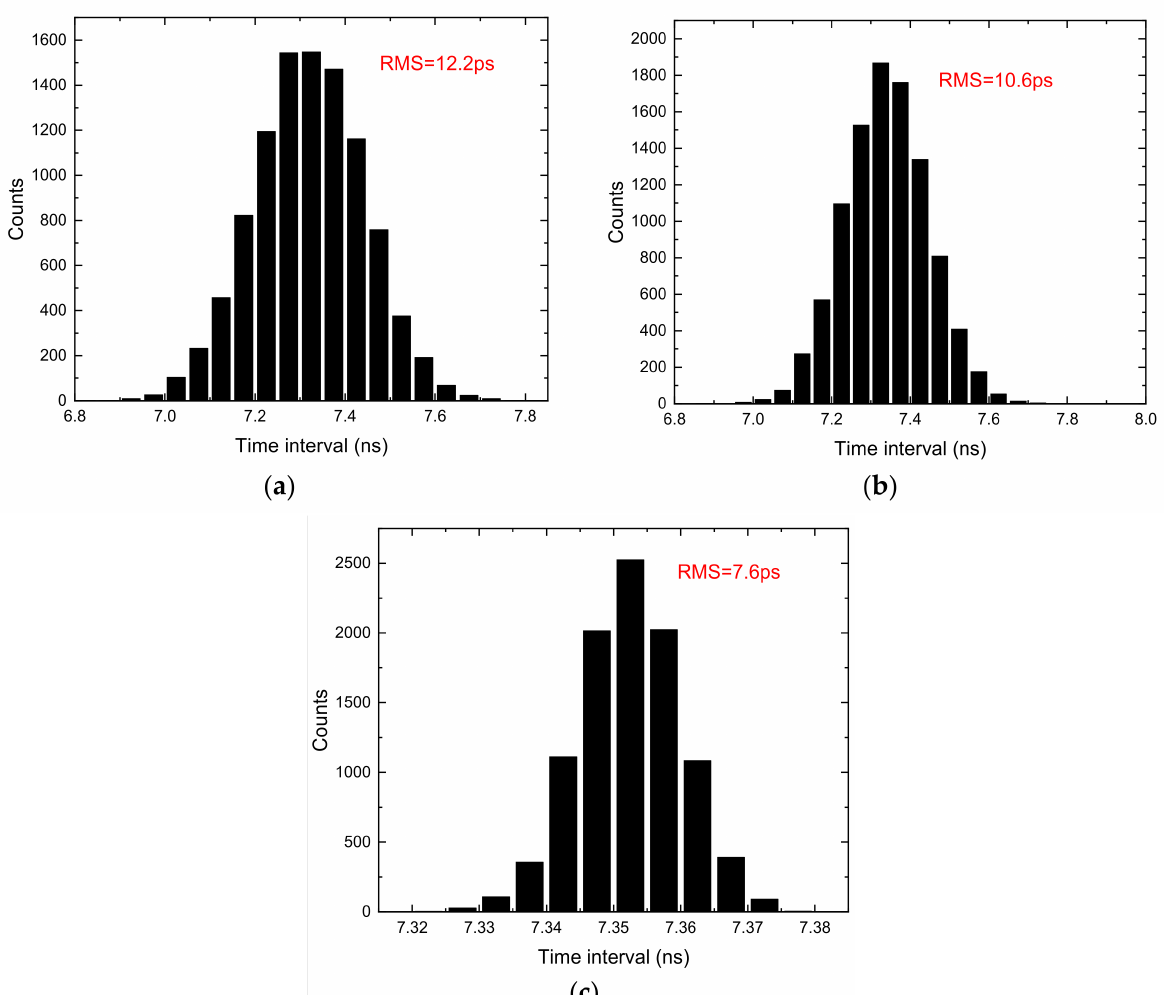
Figure 10. RMS precision of the TDC with different chain number. ( a ) Chain number = 1; ( b ) chain number = 3; ( c ) chain number =